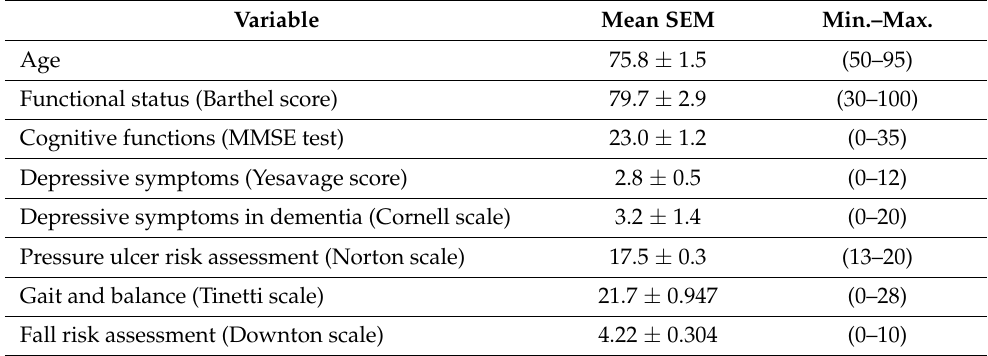
Table 1. Mean ± standard error mean (SEM) of the age and results for the scales used for geriatric